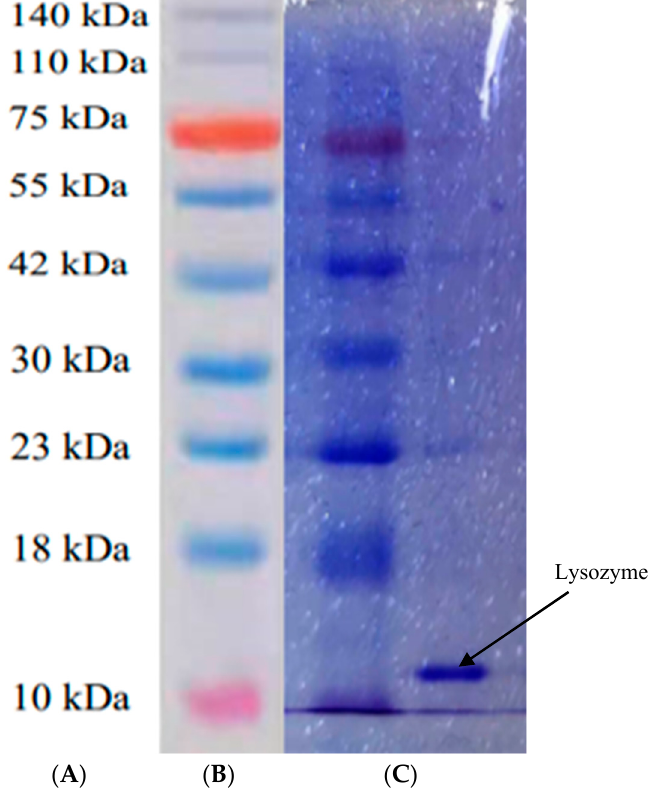
Figure 4. SDS-PAGE profile of lysozyme from SDEW. ( A ) Protein molecular quality standard, ( B ) standard protein Marker; ( C ) sample.